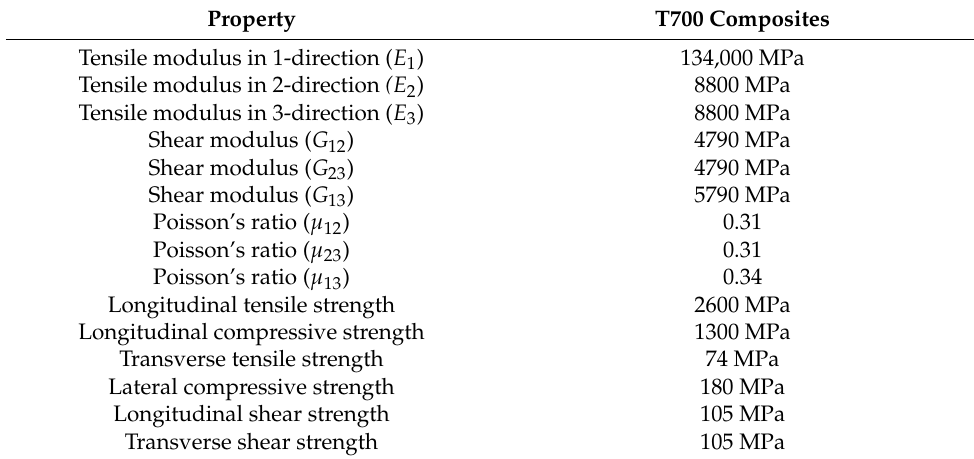
Table 1. T700/epoxy resin composite